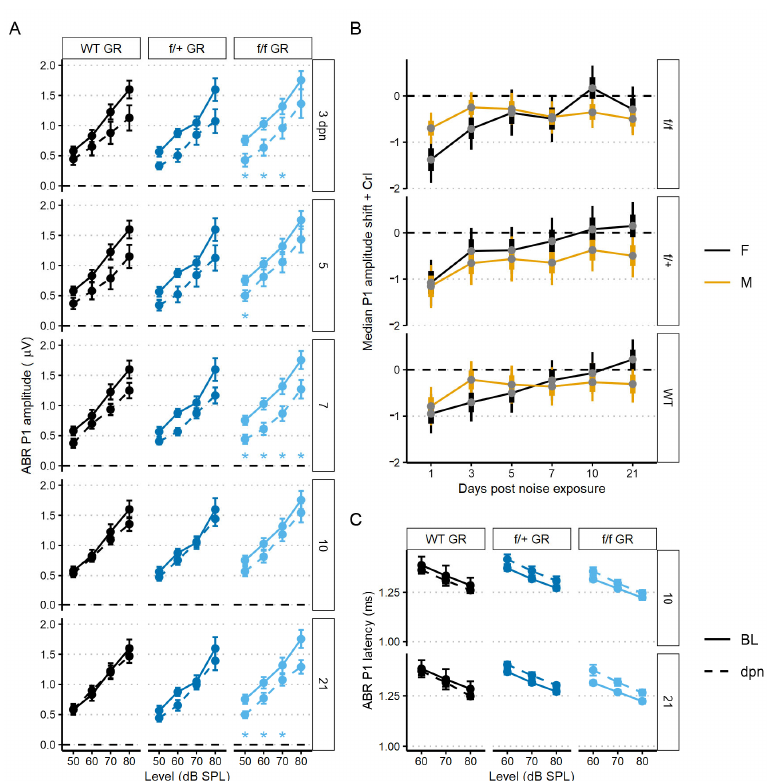
Figure 6. The 22.6 kHz ABR P1 amplitude and latency (mean ± SEM) of GR cKO and control (no tamoxifen) mice following 94 dB SPL mild noise exposure. ( A ) ABR P1 amplitude at 3, 5, 7, 10, and 21 dpn is the dashed line. Baseline P1 amplitudes are indicated by a solid line. Plots are grouped column-wise by genotype and row-wise by dpn. P1 amplitudes were suppressed in f/f cKO GR mice at all dpn, although the suppression was less at 10 dpn before increasing again by 21 dpn. ( B ) Resampled P1 amplitude shift with 22.6 kHz and 80 dB SPL sound stimulus. Plots are grouped row-wise by genotype. Male mice are indicated in yellow. ( C ) ABR P1 latency at 10 and 21 dpn is plotted with baseline P1 latency. No noise-induced changes were evident. Statistical analyses included use of linear mixed effects models for data plotted in A and C and Bayesian repeated measures for